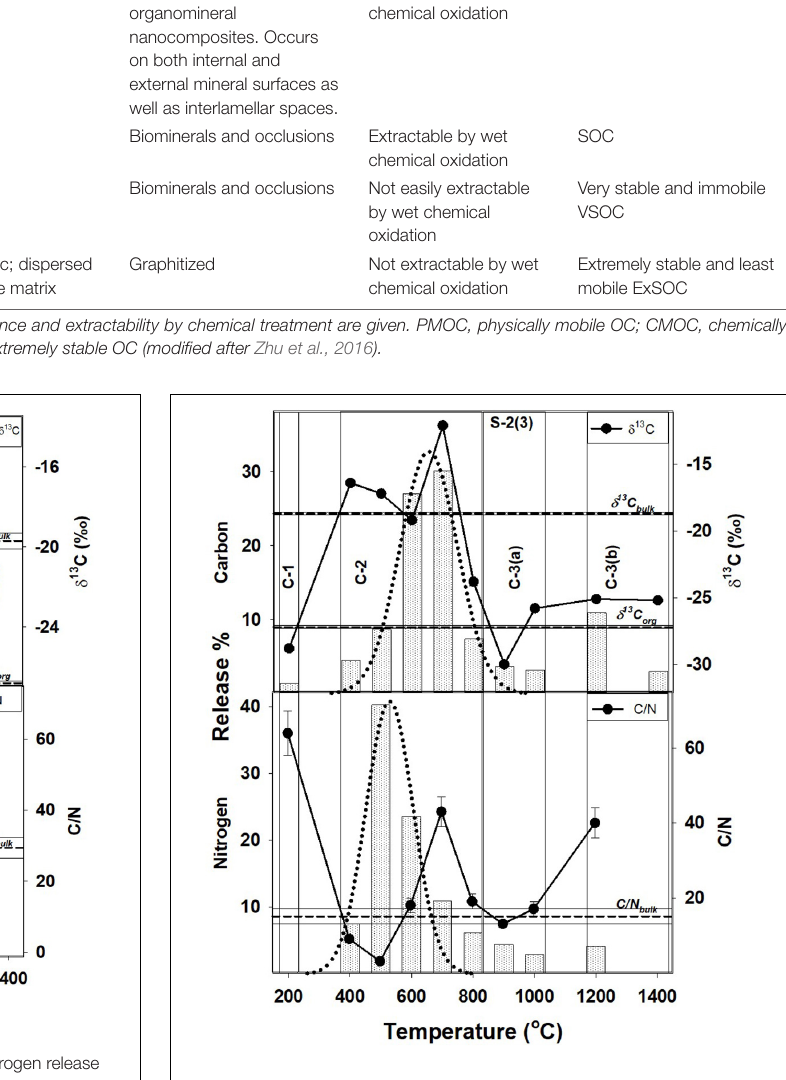
FIGURE 2 | Step combustion temperature vs. carbon and nitrogen release percent for S-2(3). The isotopic and elemental ratios for each temperature step are shown along with the bulk values and the corresponding OC components [C-1, C-2, C-3(a), and C-3(b)]. For further details, refer to text and Figure 1 .